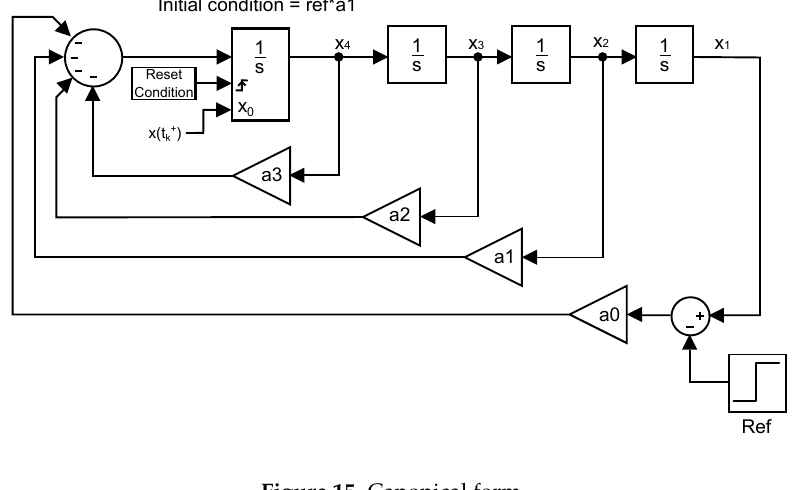
Figure 15. Canonical